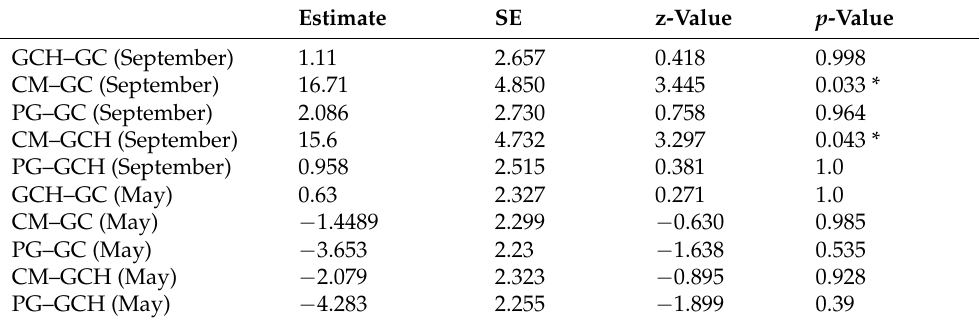
Table A5. Differences in the activity densities of eurytopic carabid beetles, comparing grass–clover (GC) and grass–clover herbs (GCH) with each other, and in comparison to conventional maize (CM) and permanent grasslands (PG) in May/June and September. p -values are indicated as * p < 0.05.